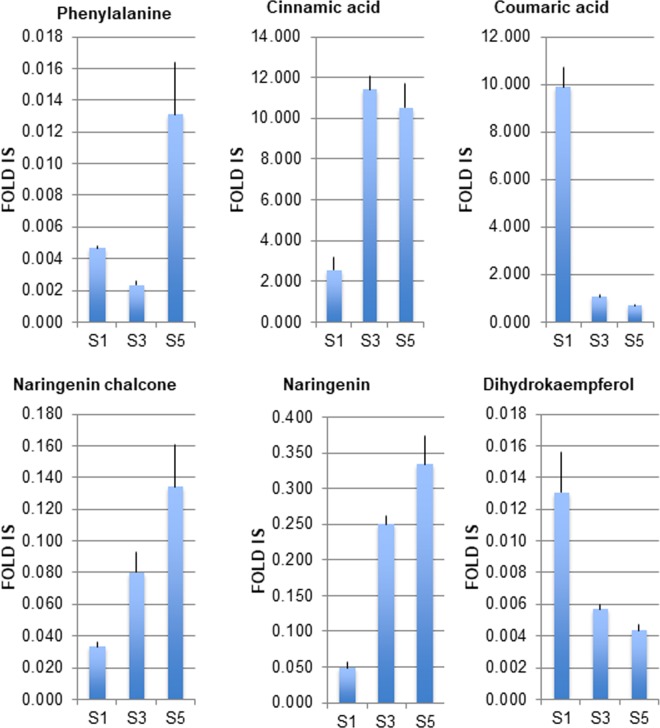
Levels of anthocyanin precursors identified in petals of Gentiana lutea L. var. aurantiaca in three different developmental stages by HPLC-ESI-MS/MS analyses.Data are expressed as average and standard deviation which represent, for each metabolite, the fold over the internal standard (IS), have been obtained by using, at least, three independent biological replicates. For more details, see Materials and Methods.